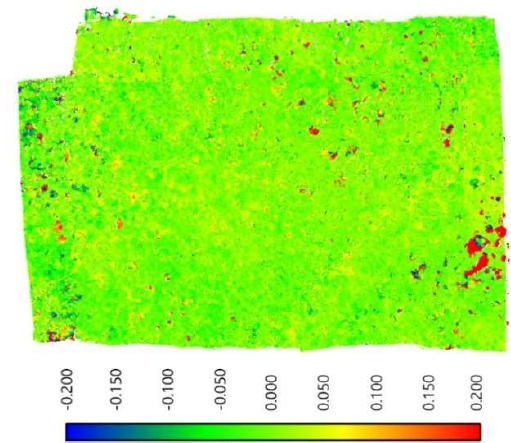
Figure 6. Colour map of distances between the photogrammetric models A1 and A2 at the maximum distance of 0.2